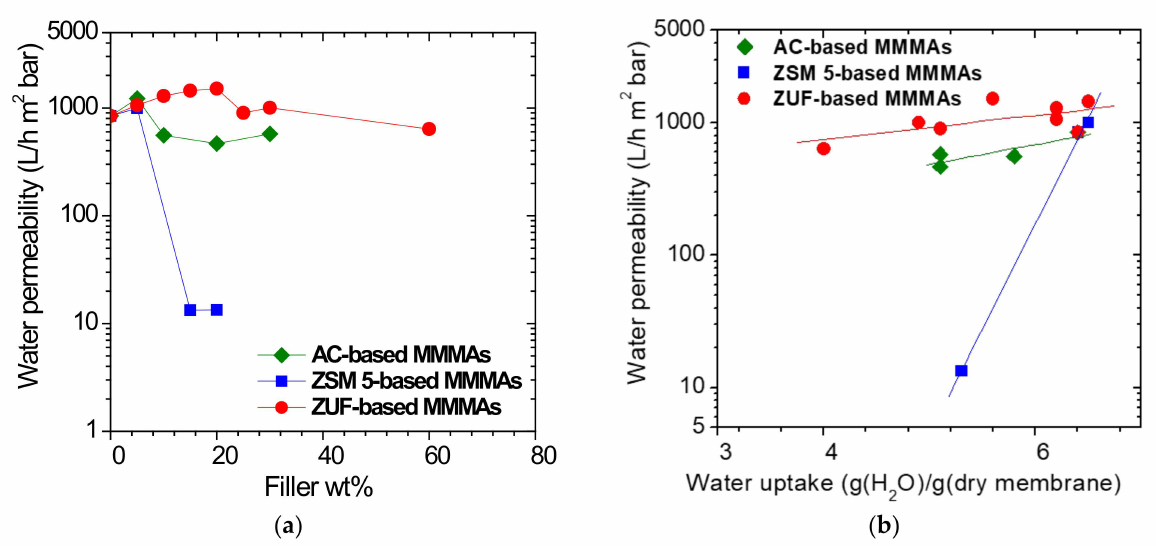
Figure 5. ( a ) Hydraulic permeability of MMMAs versus filler weight; ( b ) correlation between water permeability and water uptake in the different